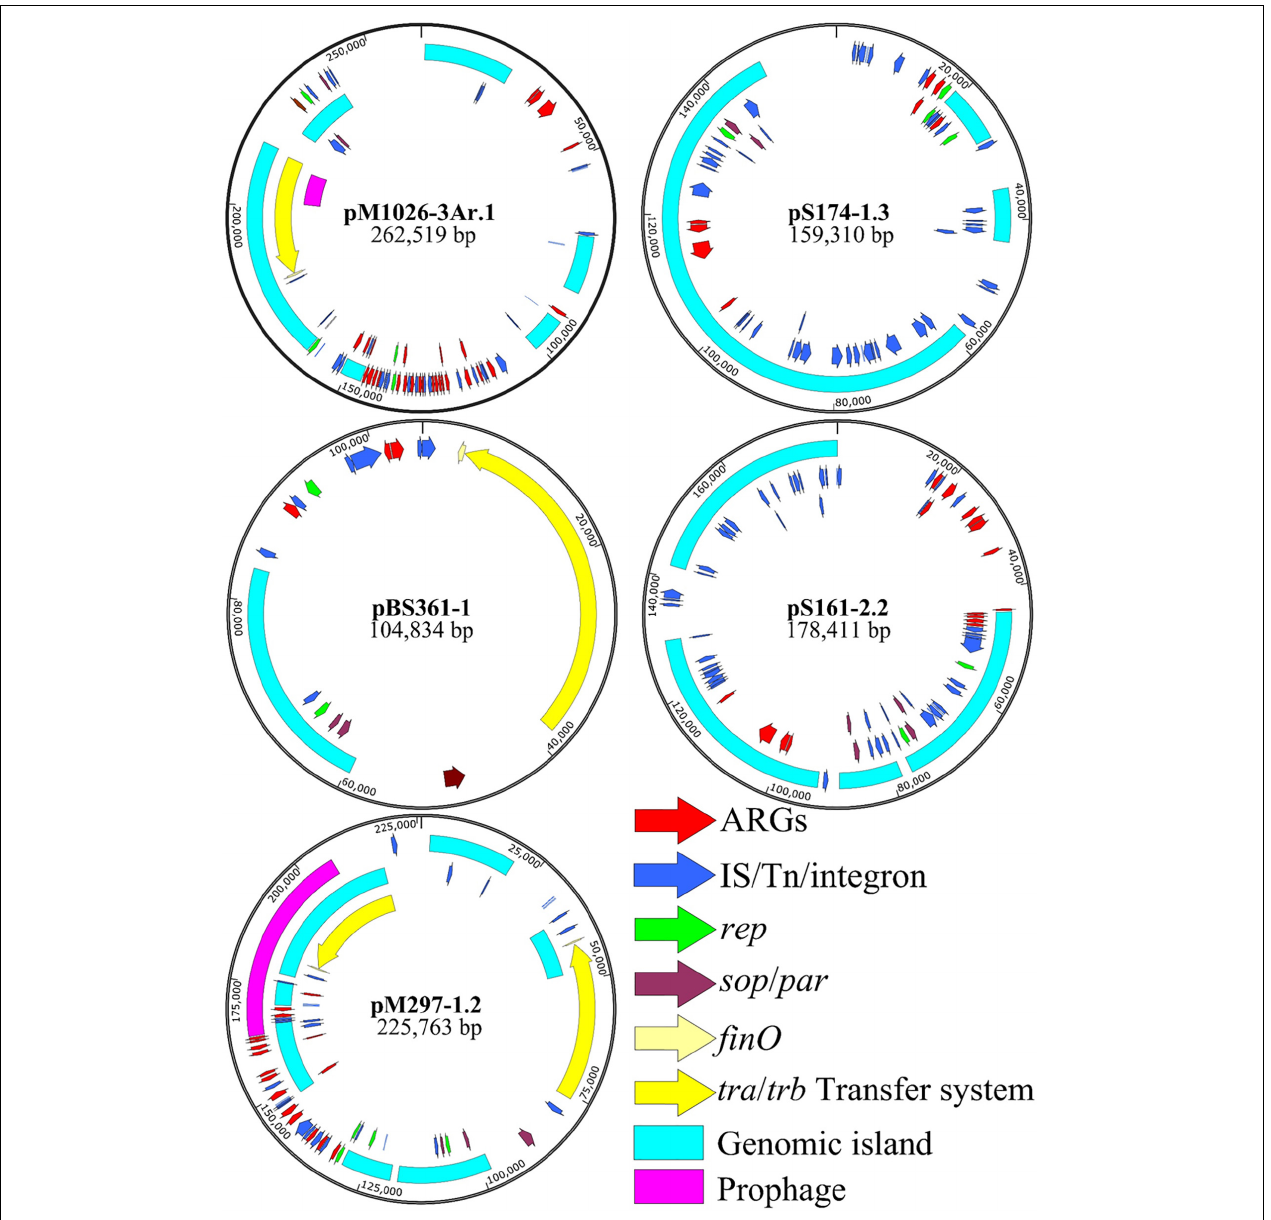
FIGURE 4 | Multiple-replicon plasmid map. pM1026-3Ar.1, pS174-1.3, pBS361-1, pS161-2.2, and pM297-1.2 were selected as representatives, and different colors represent different functional